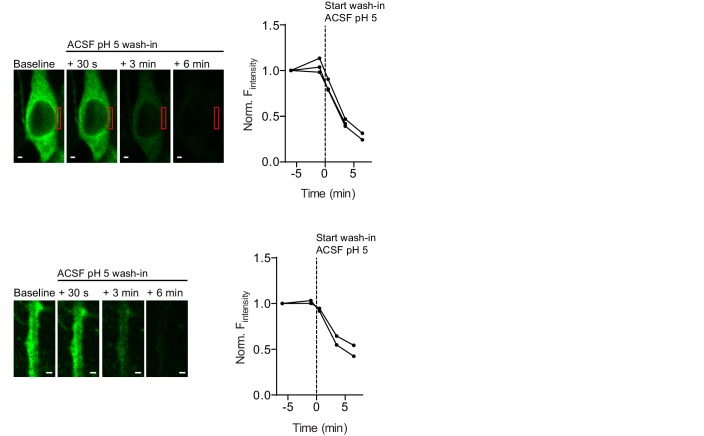
SEP-GluA3 fluorescence is pH-sensitive.Example images and average fluorescence intensity of SEP-infected GluA3-KO at the edge of cell bodies (top: n=3) or at apical dendrites (bottom: n=2) visualized with 2-photon laser scanning microscopy before and after wash-in of pH5-buffered ACSF. Scale bars indicate 5 μm.